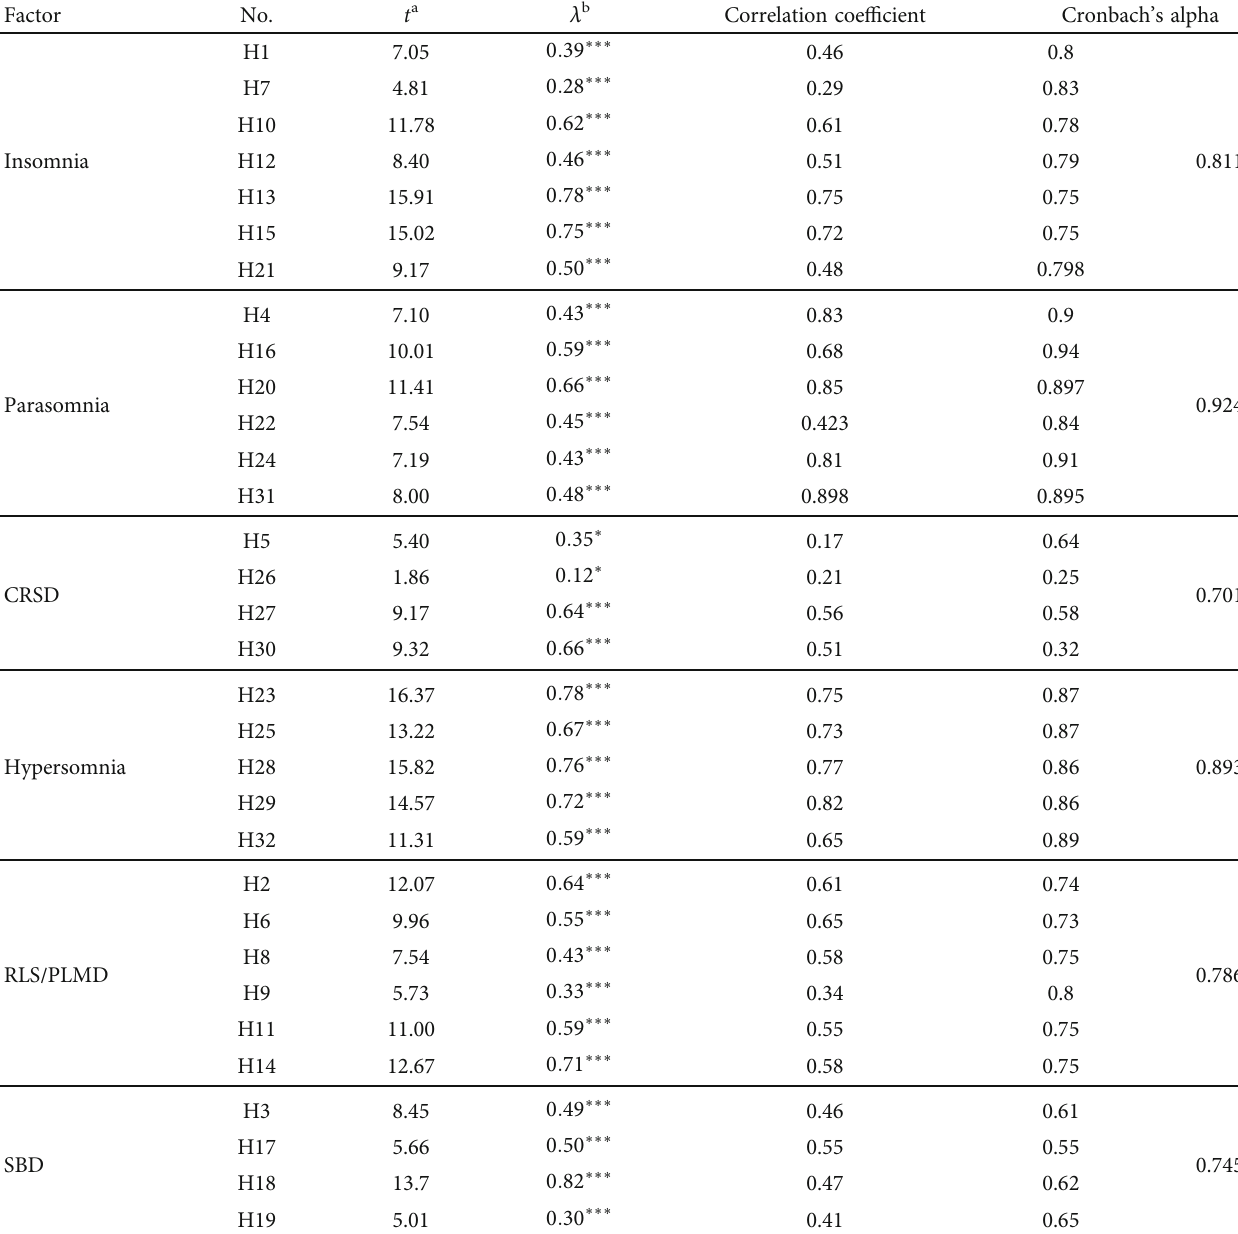
Table 5: t value, factor loading correlation, and Cronbach ’ s alpha of the tool items.